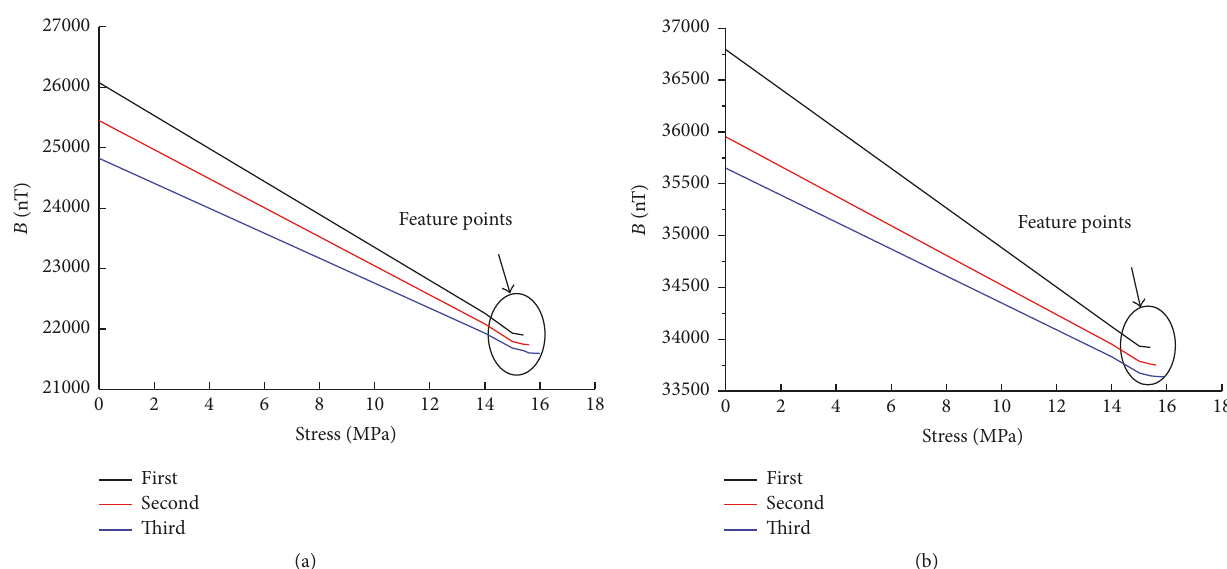
Figure 8: The signals character of magnetic memory in three experimental procedures: (a) The 𝑋 direction. (b) The 𝑌